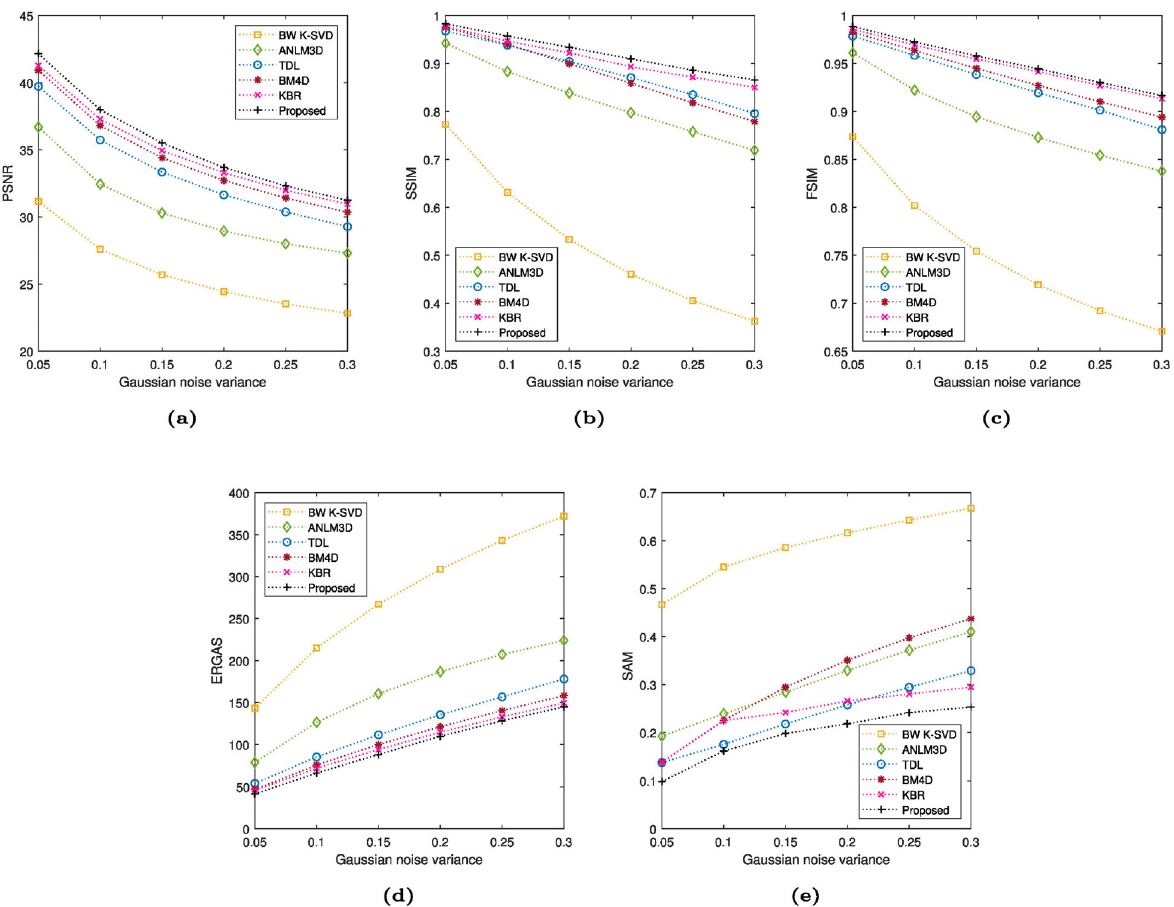
Fig. 4 Image quality index versus Gaussian noise variance for BW K-SVD [6], ANLM3D [24], TDL [14], BM4D [13], KBR [16], and the proposed method. The results were obtained by averaging over the 32 scenes. (a) PSNR; (b) SSIM; (c) FSIM; (d) EGRAS; (e) SAM.